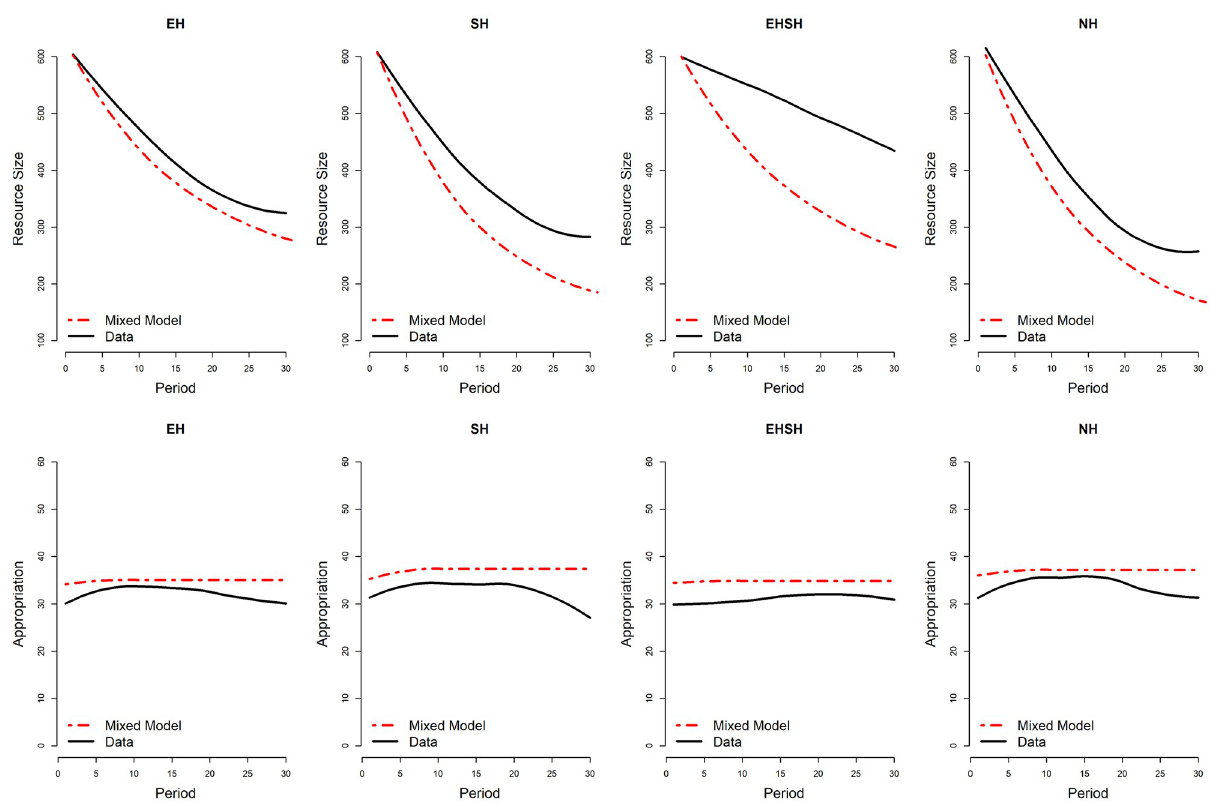
Fig 11. IND mixed model predictions for Resource Size (top row) and Appropriation Effort (bottom row).